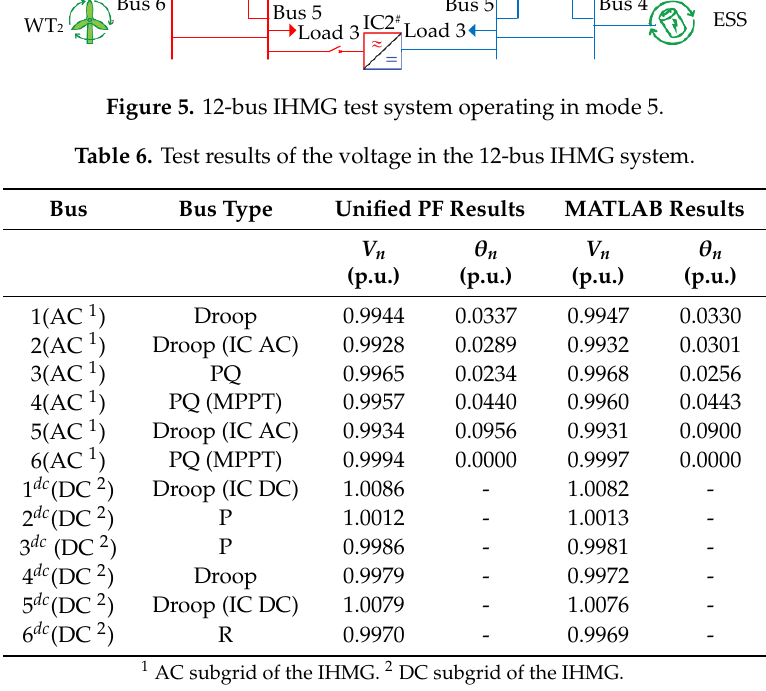
Table 7. Test results of the output power of the distributed energy resource (DER) in the 12-bus IHMG system.